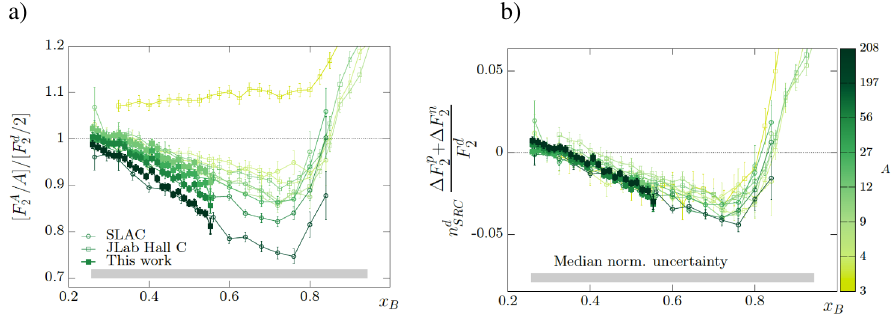
Figure 6. The EMC e ff ect for di ff erent nuclei as ratios of structure functions F A cation of SRC pairs (b) as a function of Bjorken variable x B . Color marks the mass of the nucleus. The open circles are the SLAC data [24] and the open circles are the JLab data [25]. The gray bands show the median normalization uncertainty. Pictures are adapted from